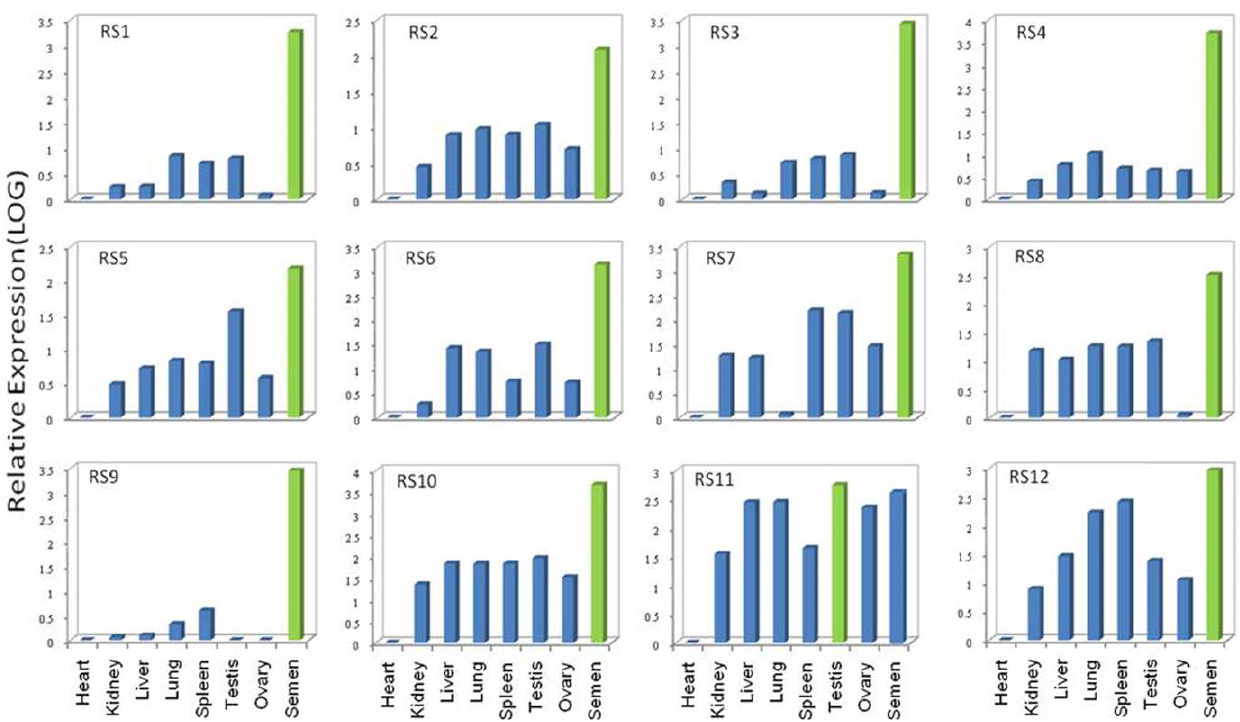
Figure 5. Quantification of mRNA transcripts originating from semen samples. Except forRS11, all mRNA transcripts were most highly expressed in the semen samples (green). To obtain a comparative profile, subsequent q-PCR using internal primers was conducted on all cDNA samples.